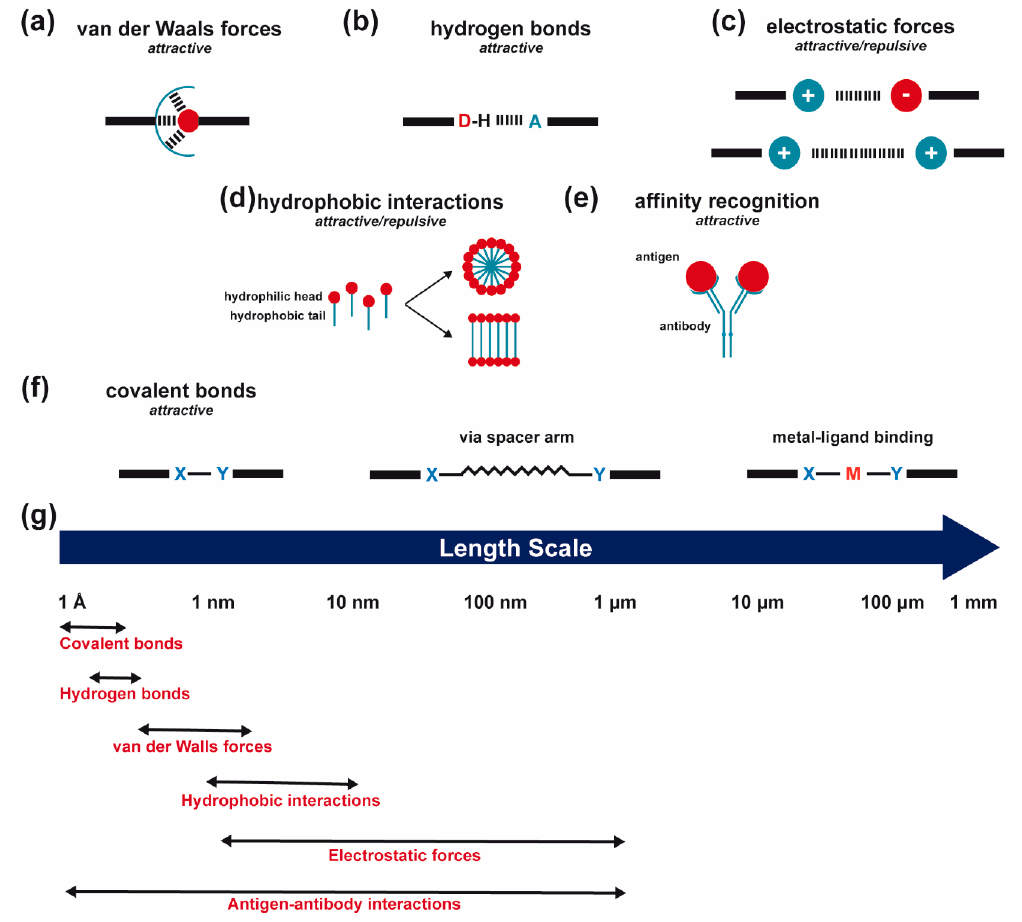
Figure 4. Forces involved in biomolecules immobilization onto natural fibers. ( a ) van der Waals forces; ( b ) hydrogen bonds between a H-bond donor and a H-bond acceptor; ( c ) electrostatic interactions between oppositely, or likely, charged species; ( d ) hydrophobic effects (here represented in the form of micelles or bilayers); ( e ) example of affinity recognitions, such as an antigen–antibody interaction; ( f ) covalent bond between donors X and Y without a spacer arm (left), via a spacer arm (middle) and metal–ligand binding between a soluble metal acceptor center (M) and organic ligand donors (X and Y) (right); and ( g ) length scales of the forces involved, taking into account that hydrophobic interactions occur upon contact, and that antigens are bound to antibodies through electrostatic interactions, hydrogen bonds, van der Waals forces and hydrophobic interactions [180,181,185– 189,199,200].